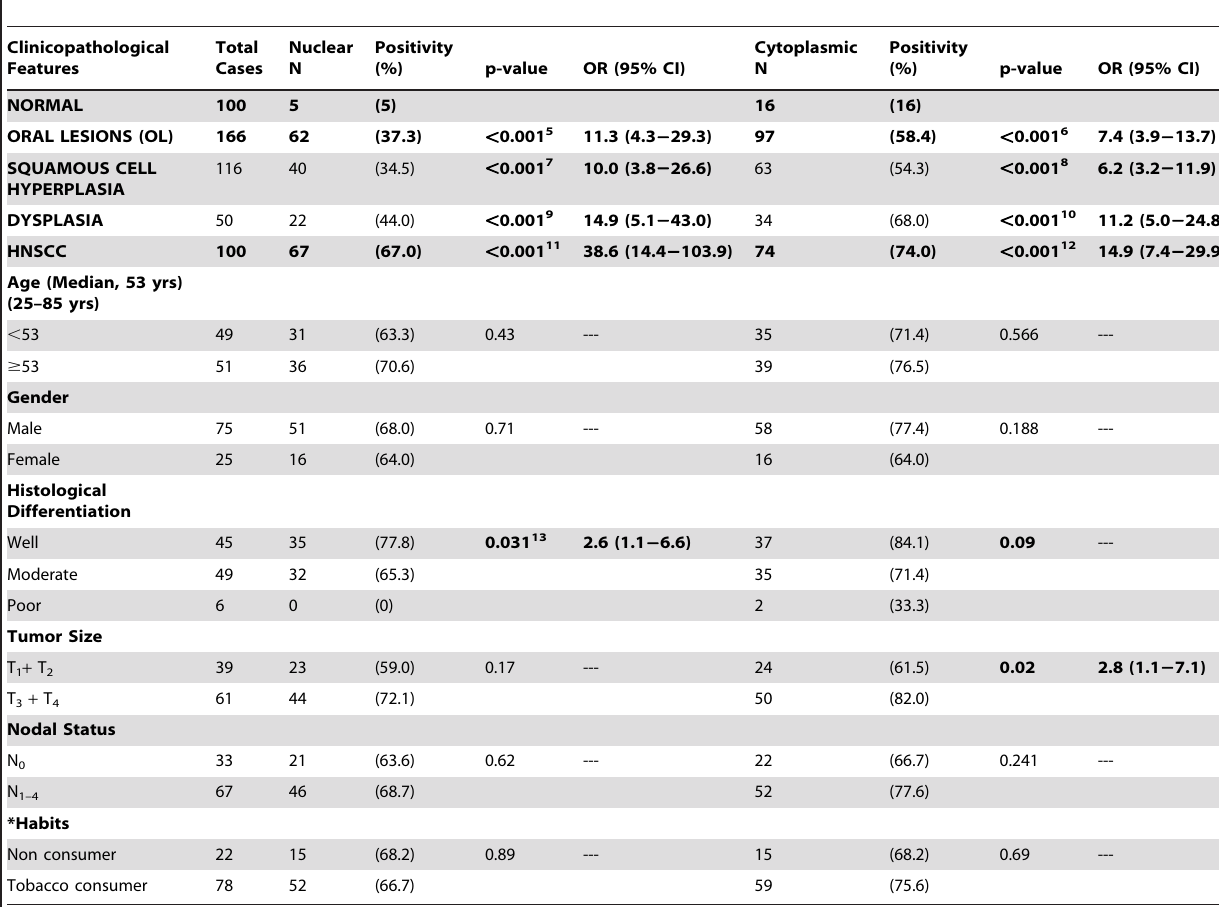
Table 1. Analysis of S100A7 protein expression in Oral Lesions and its correlation with clinicopathological